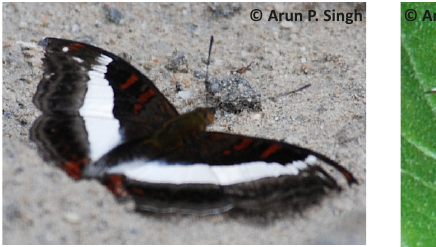
Image 11. White Commodore Parasarpa dudu dudu Westwood